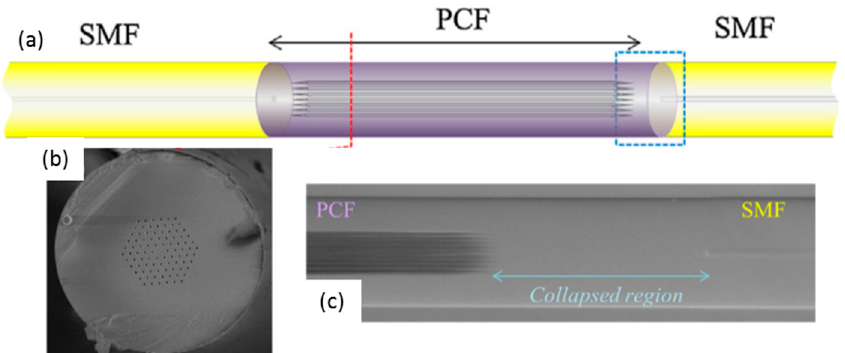
Figure 15. ( a ) Scheme of an interferometer based on a PFC segment spliced between two SMF; ( b ) SEM image of the PFC section; ( c ) optical microscope capture of the interferometer, delimiting the three different parts. Reprinted from [60] with the permission from Elsevier.